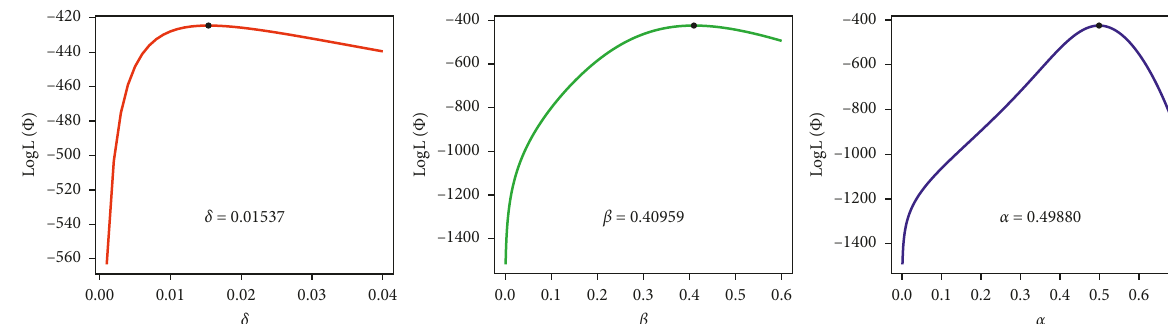
Figure 8: The profiles of the log LF of the NFLog-Wei distribution using Data 2.